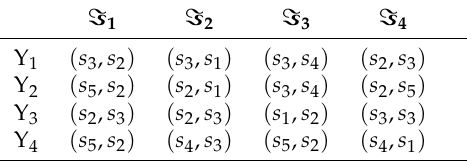
Table 7. Decision matrix R 2 by expert Z 2 .